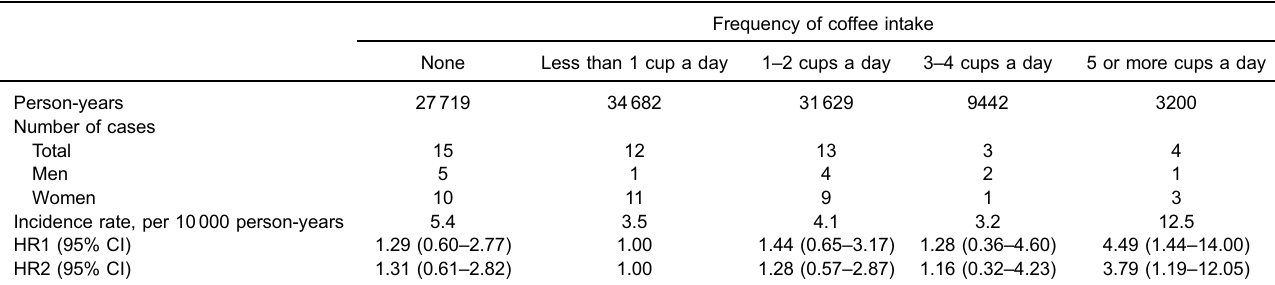
Table 2. Hazard ratios and 95% con fi dence intervals for the incidence of subarachnoid hemorrhage by frequency of coffee intake adjusted for potential cardiovascular